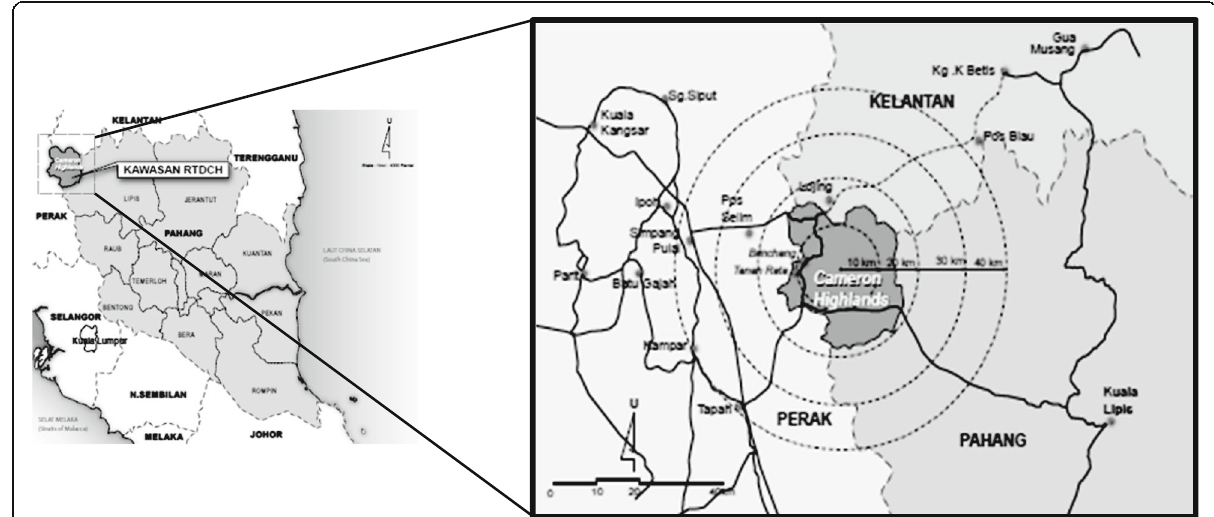
Fig. 1 Case study location located in Cameron Highlands, the smallest district in Pahang, Peninsular Malaysia (RTD